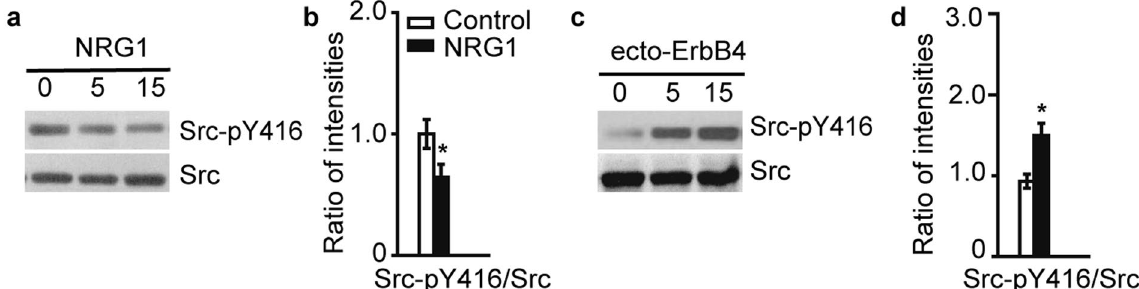
Figure 4. Src kinase is regulated by NRG1-ErbB4 signaling in the human brain. ( a ) NRG1 decreased the phosphorylation of Src at Y416 in the human temporal cortex. ( b ) Statistical analysis of phosphorylated Src at Y416 (n = 8). ( c ) Ecto-ErbB4 (2 μ g/ml) treatment markedly increases Src-pY416 in the human brain. ( d ) Quantification of Src-pY416 immunoblots (n = 5). * P < 0.05. Unpaired two-tailed Student’s t-test. Data are represented as the mean ± s.e.m.